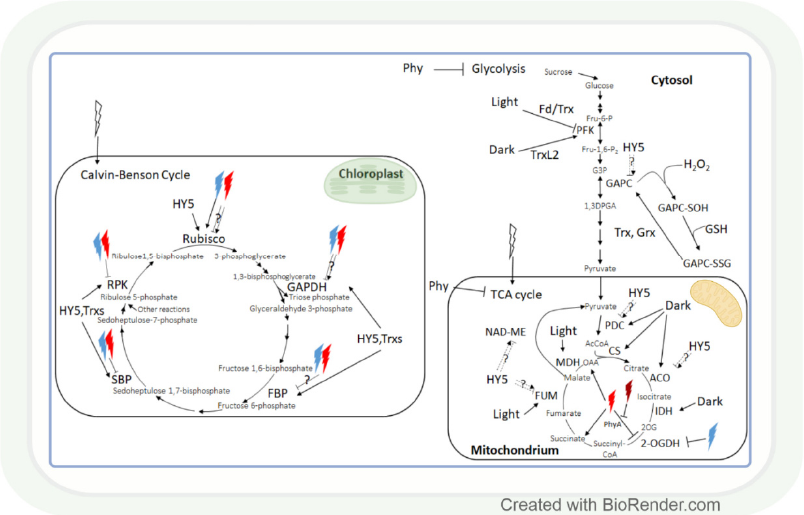
Figure 4. The effect of light intensity and spectrum on carbohydrate metabolism. Monochromic red or blue lights may inhibit or enhance the enzymes of the Calvin–Benson cycle. Most of these enzymes are HY-5 and/or Trx-regulated. Interestingly, several enzymes of carbohydrate catabolism are light re- pressed, while others are light enhanced. Light-associated redox regulation of the Calvin–Benson